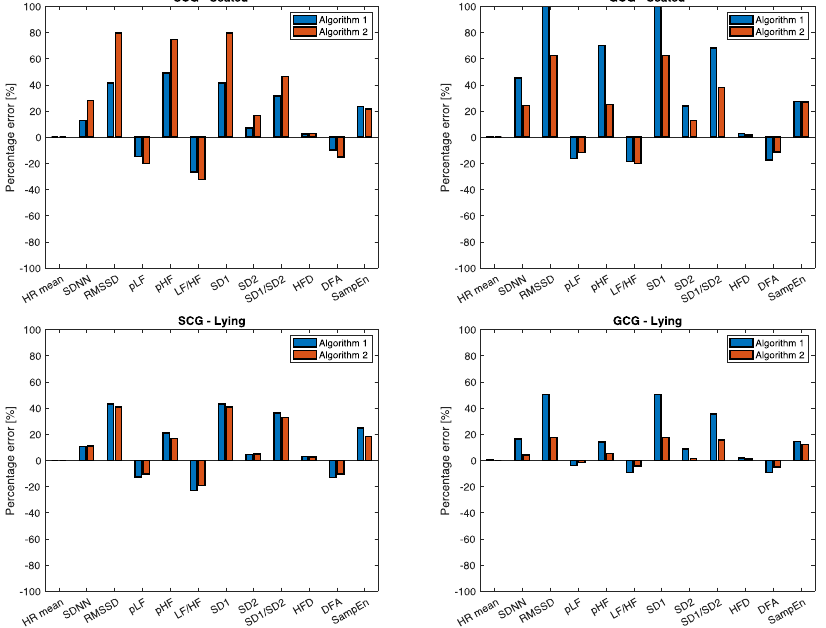
Figure 7. Percentage error between HRV derived from 𝐼𝐵𝐼 (cid:3002)(cid:3016)(cid:3002)(cid:3016) estimated from SCG and GCG sig- nals and from 𝐼𝐵𝐼 (cid:3019)(cid:3019) from ECG signal. All the errors are reported in %.